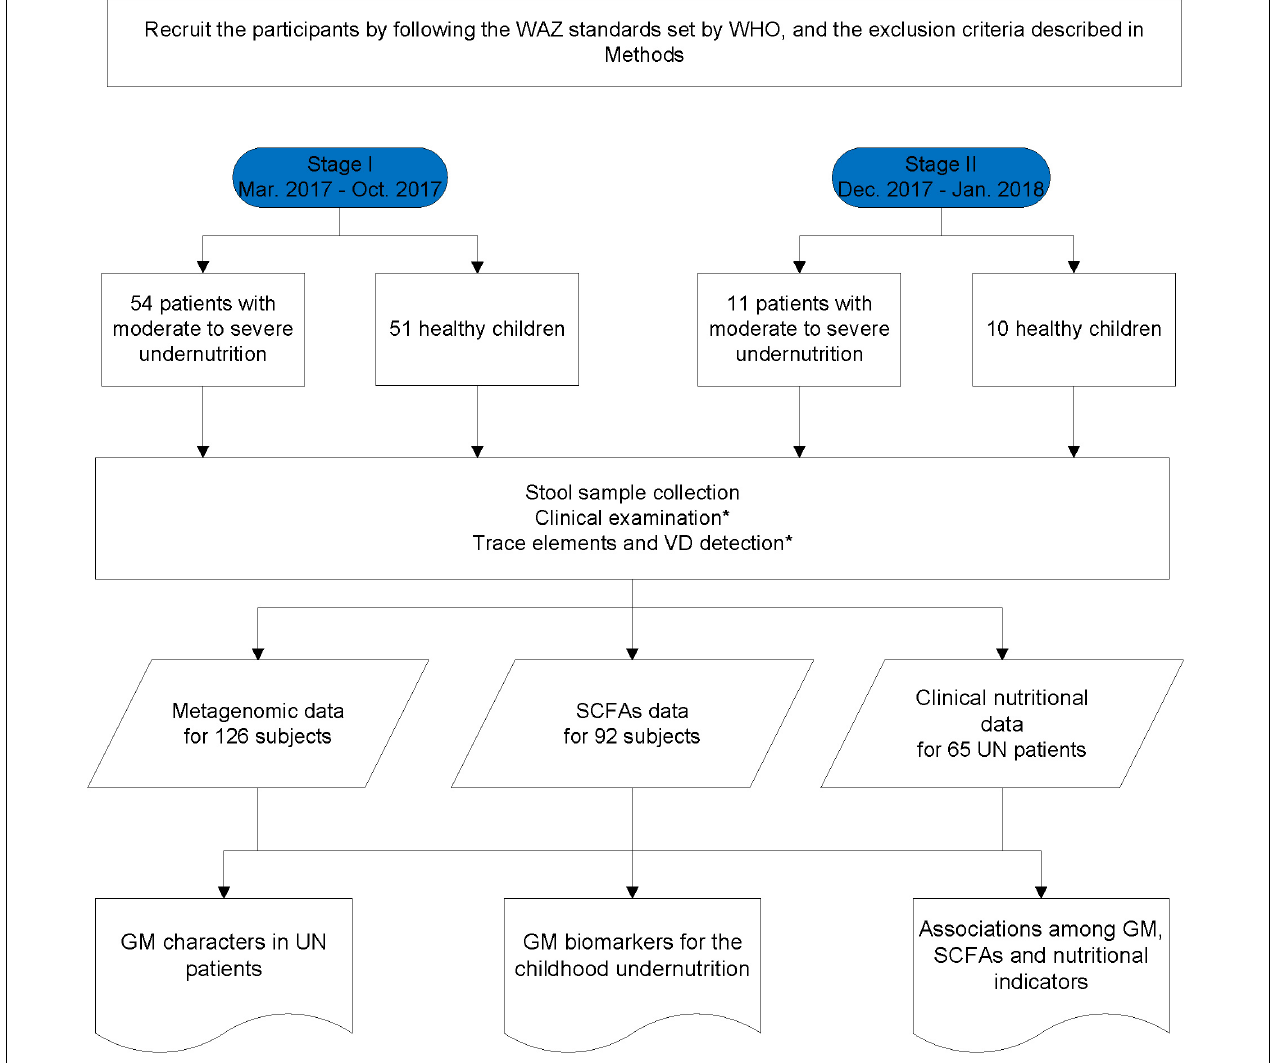
FIGURE 1 | Flow diagram of participant selection and data acquisition. ∗ Means the data was only obtained in the UN